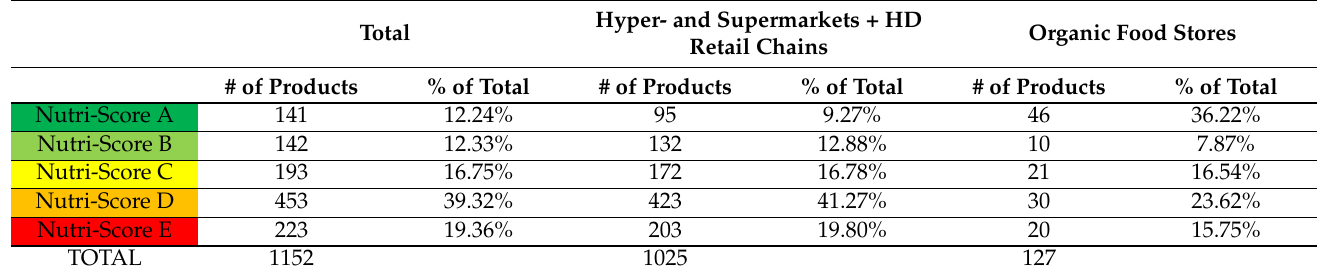
Table 2. Breakdown of Nutri-Score group by store type.